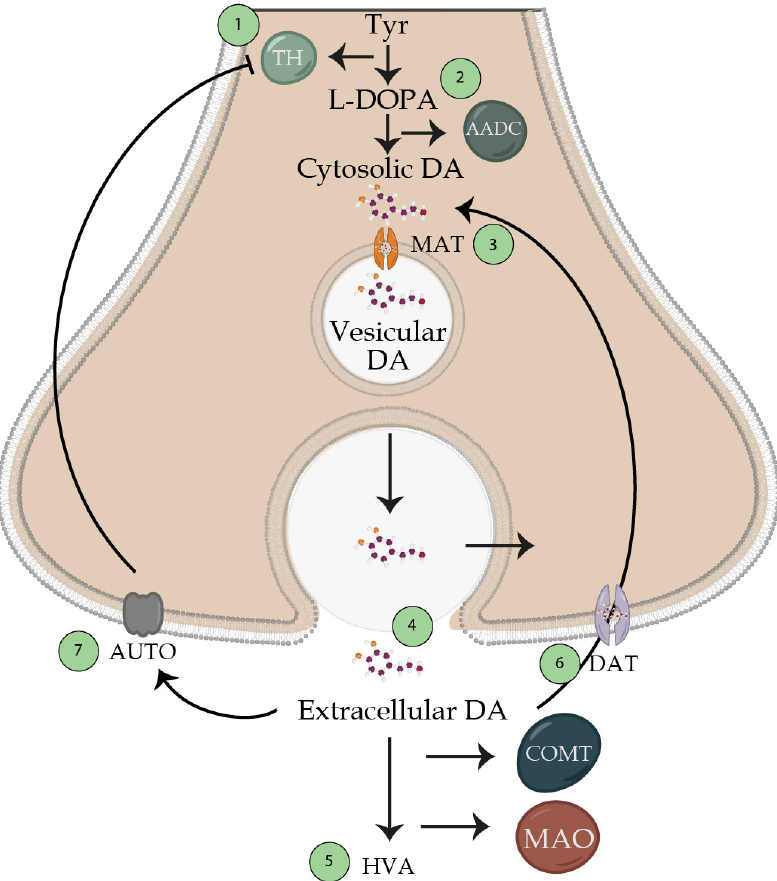
Figure 4. Dopamine synthesis. Schematic representation of the synthesis of the neurotransmitter dopamine. 1. Produced from the amino acid tyrosine, which passes through tyrosine hydroxylase, which generates L-DOPA. This enzyme is the one that limits the production of dopamine (which is inhibited by high concentrations of its substrate tyrosine). 2. Transformation of L-DOPA into dopamine by the aromatic amino acid decarboxylase enzyme, which is found in a cytosolic way and is not active for the release with the action potentials. 3. Transport of cytosolic dopamine to vesicles via the vesicular monoamine transporter enzyme. 4. The potential action releases dopamine to the synaptic cleft, so it reaches its receptor and generates its function. These nerve terminals will be found in the circuits already mentioned in the text; however, we can find a tonic release at a frequency of 5 Hz, and another 10–15 Hz interburst release. 5. Extracellular dopamine will be metabolized by catecholamine O-methyl transferase and mono-amino oxidase towards homovalinic acid. 6. Presynaptic receptors will recapture unmetabolized dopamine for reuse. 7. Unmetabolized dopamine may bind to presynaptic receptors to block tyrosine hydroxylase. Abbreviations: Tyr, tyrosine; TH, tyrosine hydroxylase; AADC, aromatic acid decarboxylase; MAT, monoamine transporter; DAT, dopamine transporter; MAO, monoamine oxidase; COMT, catecholamine O-methyl